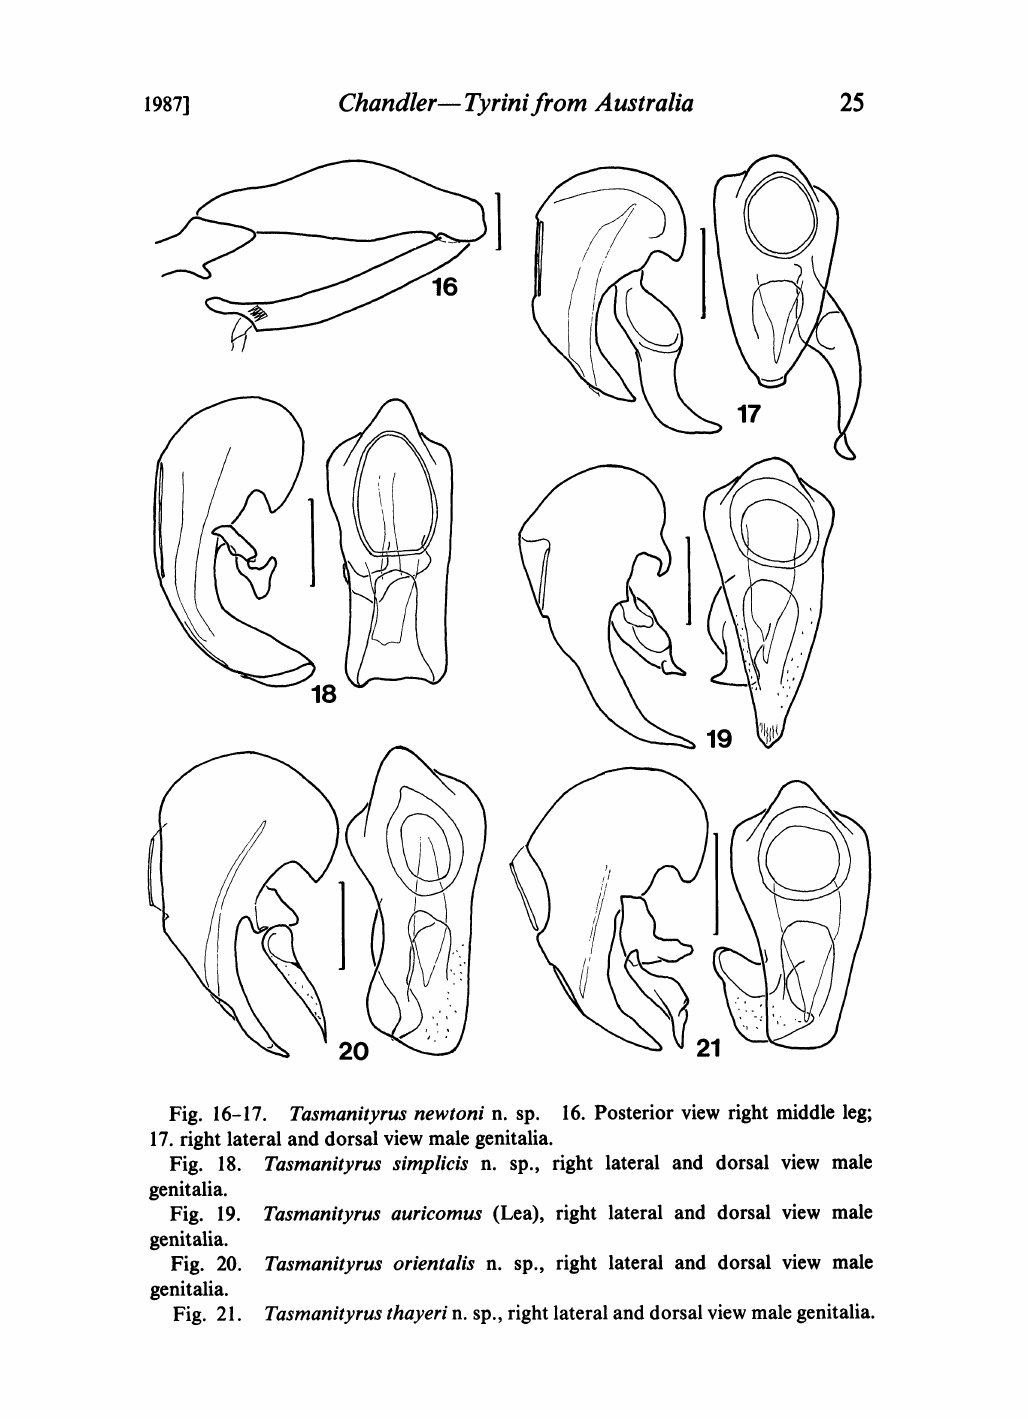
Fig. 16-17. Tasmanityrus newtoni n. sp. 16. Posterior view right middle leg; 17. right lateral and dorsal view male genitalia. Fig. 18. Tasmanityrus simplicis n. sp., right lateral and dorsal view male genitalia. Fig. 19. Tasmanityrus auricomus (Lea), right lateral and dorsal view male genitalia. Fig. 20. Tasmanityrus orientalis n. sp., right lateral and dorsal view male genitalia. Fig. 21. Tasmanityrus thayeri n. sp., right lateral and dorsal view male